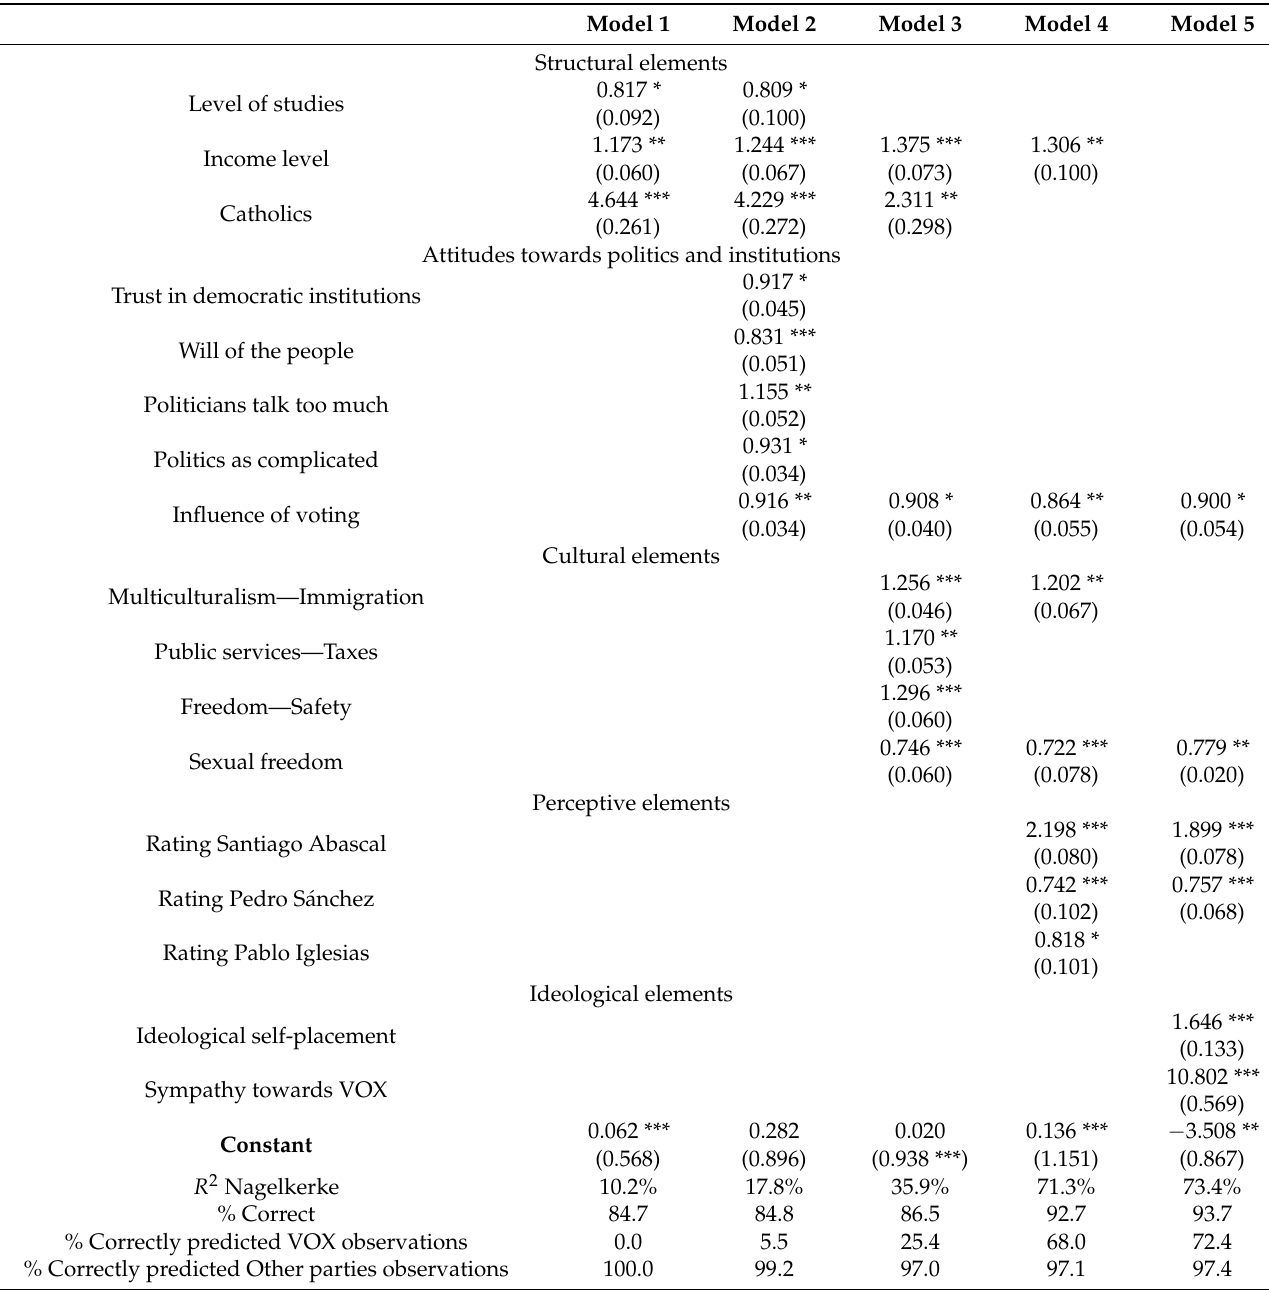
Table 4. Explanatory models of the hope for Santiago